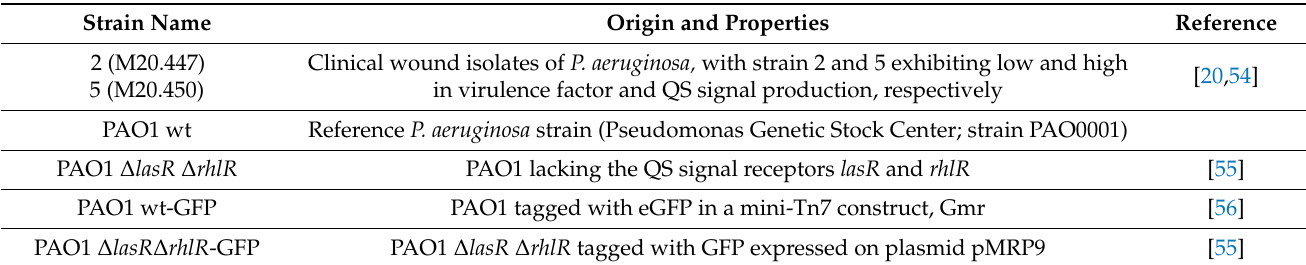
Table 1. Pseudomonas aeruginosa strains used in this